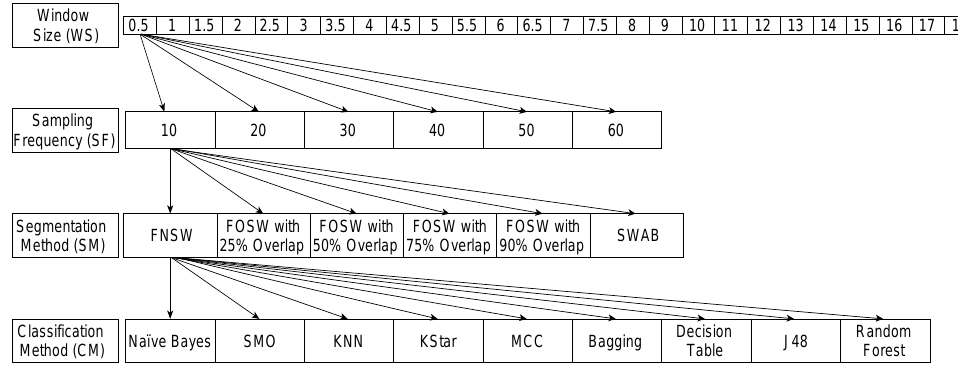
Figure 4. Parameter combinations for each